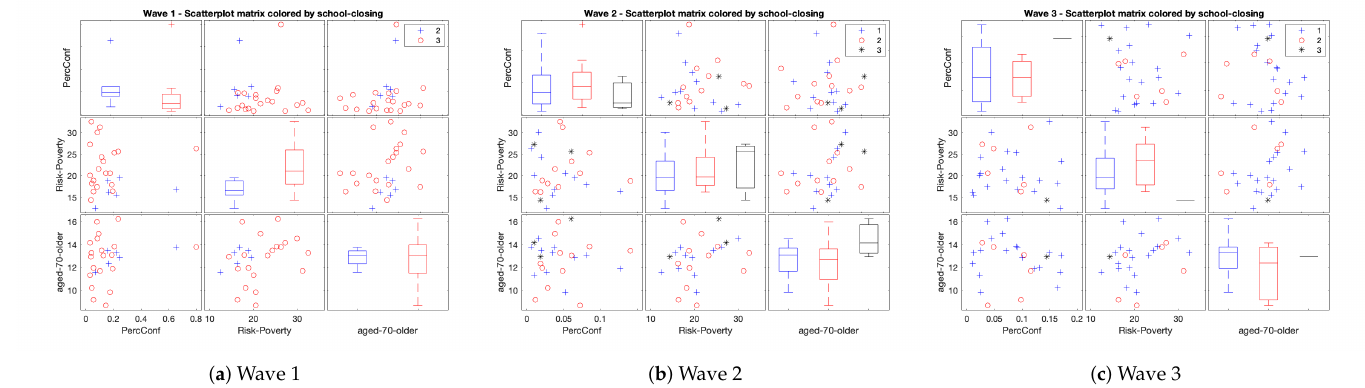
Figure 2. Exploratory step: Multiple scatter-plots for PercConf , 2019_Risk_Poverty and aged_70_older ) colored by school_closing .